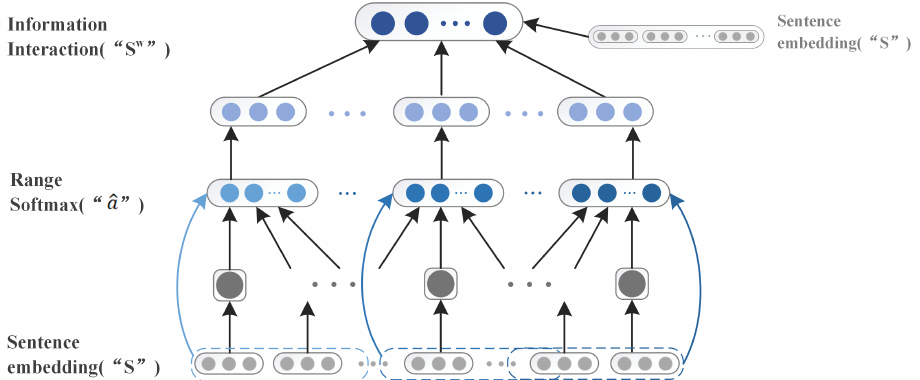
Figure 3. The processing based on span representation is described in detail, where S represents the sentence representation vector output by